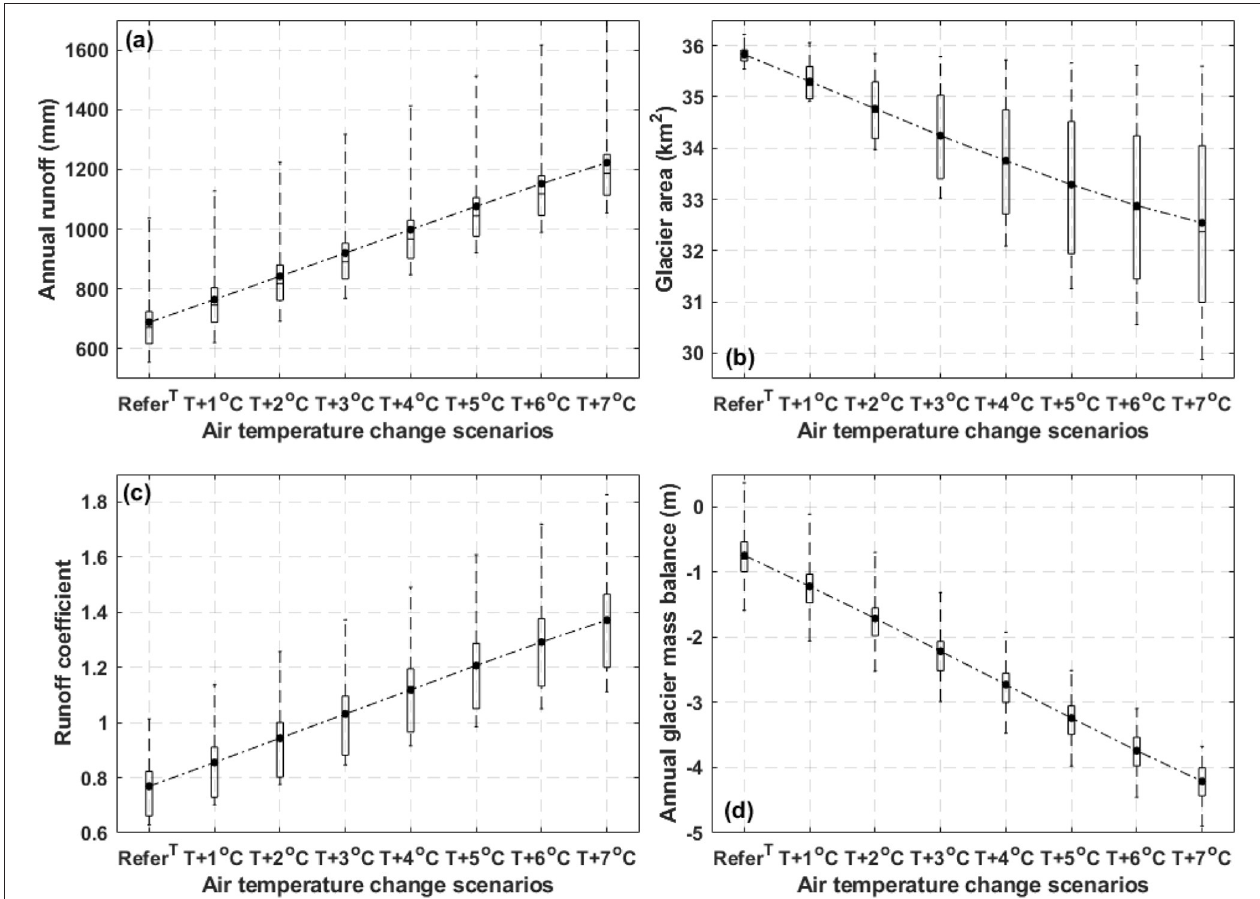
FIGURE 3 | Sensitivities of hydrological variables to temperature warming. Boxplots indicate the inter-annual variabilities of hydrological variables during the 20-year modeling period, and dots indicate mean values during the modeling period. (a) for the sensitivity of annual runoff, (b) for glacier area, (c) for runoff coefficient, and (d) for annual glacier mass balance.